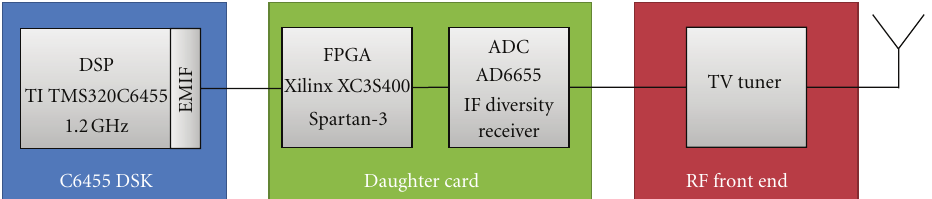
Figure 8: Spectrum sensing entity.